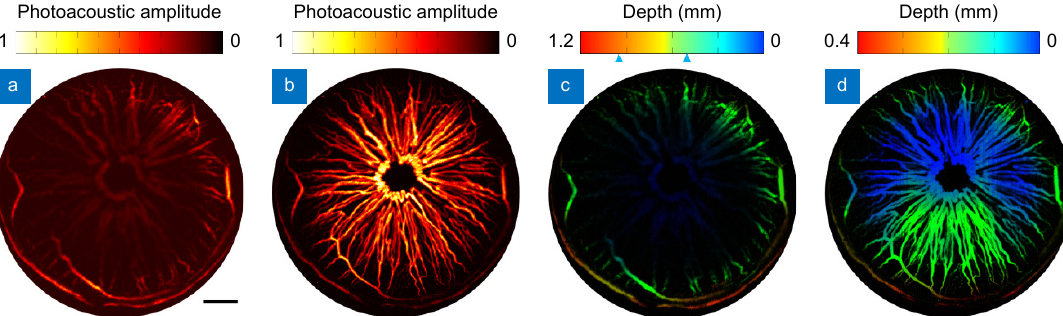
Fig. 4 | ( a−b ) The MAP images of a representative mouse scanned by conventional OR-PAM and the new method developed in this study. ( c−d ). The depth encoded images of (a−b), respectively. Scale bar=0.5